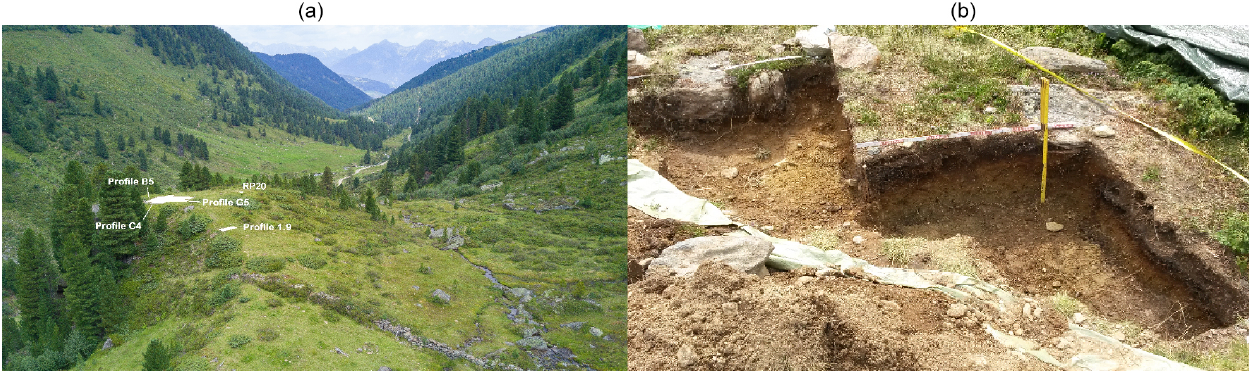
Figure 2. (a) NNW view over the Ullafelsen in the Fotsch Valley, Stubai Alps, Austria, at the upper timberline. The geoarcheological excavation area on the Ullafelsen plateau with the reopened and sampled soil profiles 1.1B5, 1.1C4 and 1.1G5 and the newly opened and sampled soil profile 1.9 several meters towards the southeast are shown. (b) Reopened archeological excavation area. View to the southwestern part of the sampled soil profiles (Zech et al., 2021).